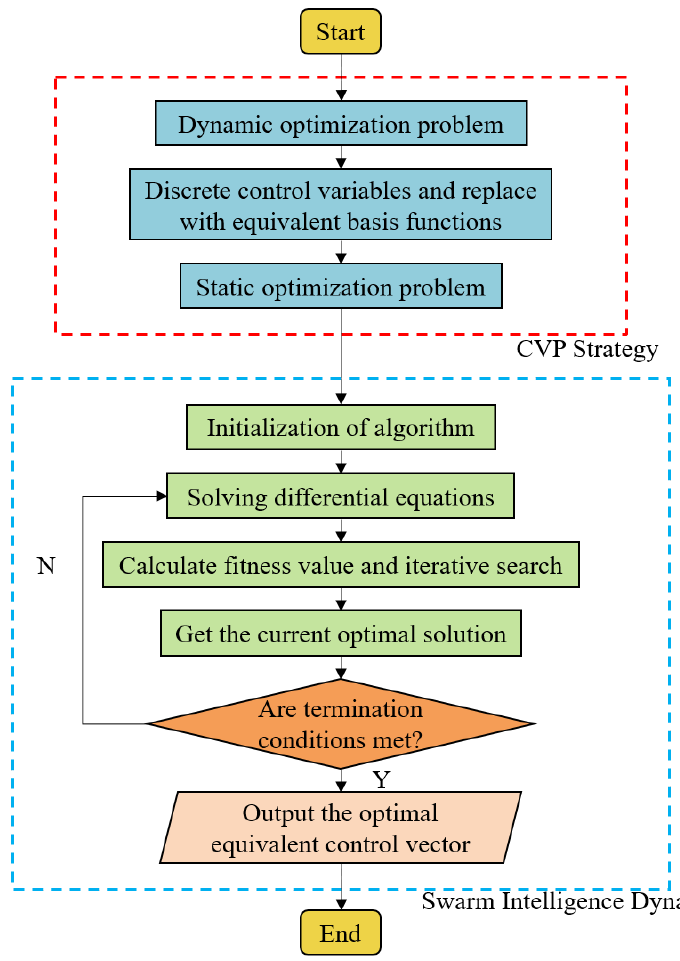
Figure 2. Swarm-Intelligence Dynamic Optimization Method Based on CVP Strategy.